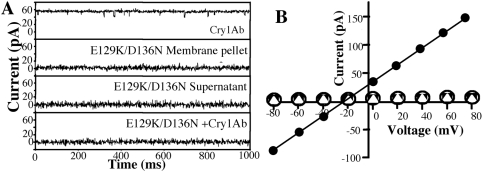

In vitro analysis of the Dominant Negative phenotype of E129K/D136N mutant.Pore formation activity of oligomeric structures obtained as described in figure 2C. Panel A, Representative ionic channel records in lipid bilayers of most common transitions induced by oligomer structures of Cry1Ab, E129K/D136N and a 1∶1 mixture of Cry1Ab: E129K/D136N. The observed responses with wild type Cry1Ab showed stable channels with high open probability. No ionic channels were observed either for the double mutant E129K/D136N or for the 1∶1 mixture of Cry1Ab with the double mutant. Records were obtained in 300∶10 mM KCl (cis:trans), 10 mM CHES pH 9, at +60 mV. Panel B, Current/voltage (I/V) relationship of macroscopic currents induced by oligomers of Cry1Ab (•) and by oligomers produced from a 1∶1 mixture of Cry1Ab and E129K/D136N (▵). The activity of the E129K/D136N mutant was also analyzed in the two fractions obtained after activation, the membrane pellet (○), and supernatant fraction (▪).